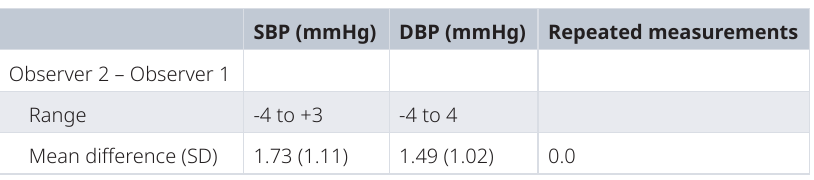
Table 5. Observer